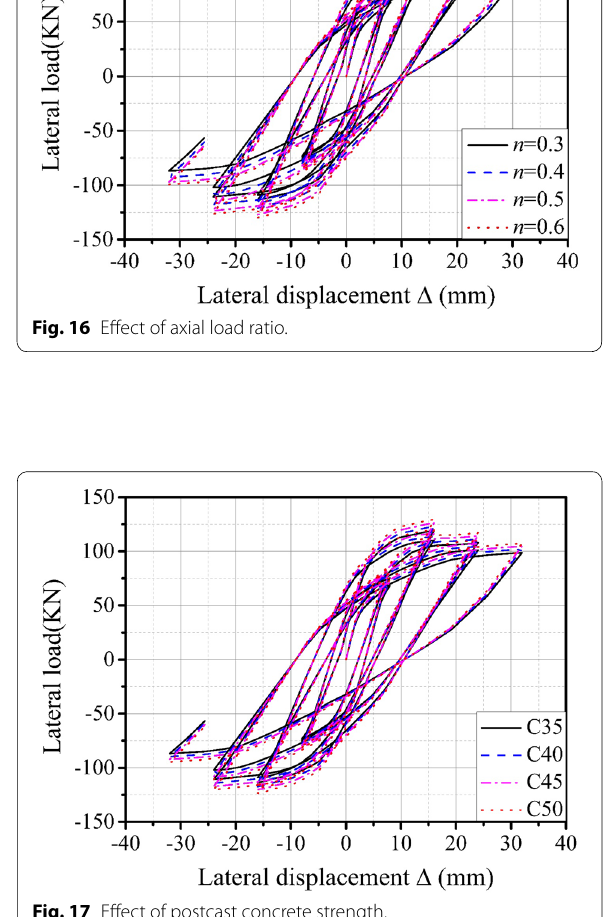
Fig. 17 Effect of postcast concrete